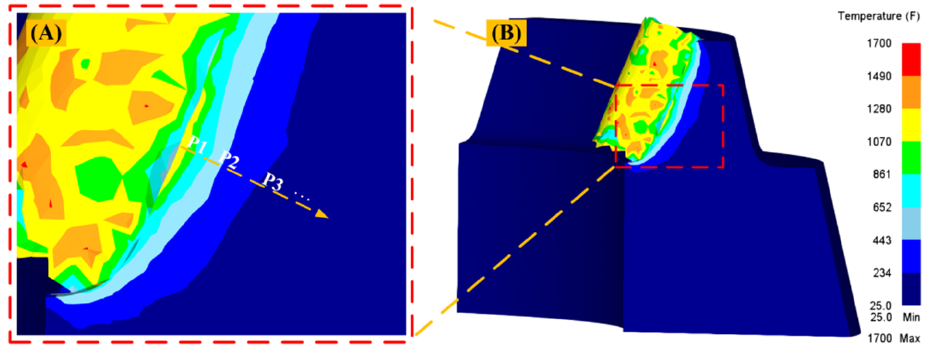
Figure 9. Schematic diagram of extraction of cutting temperature field, strain rate, and strain. ( A ) The temperature field of machined section. ( B ) The direction of data extraction of temperature and deformation of machined sections.